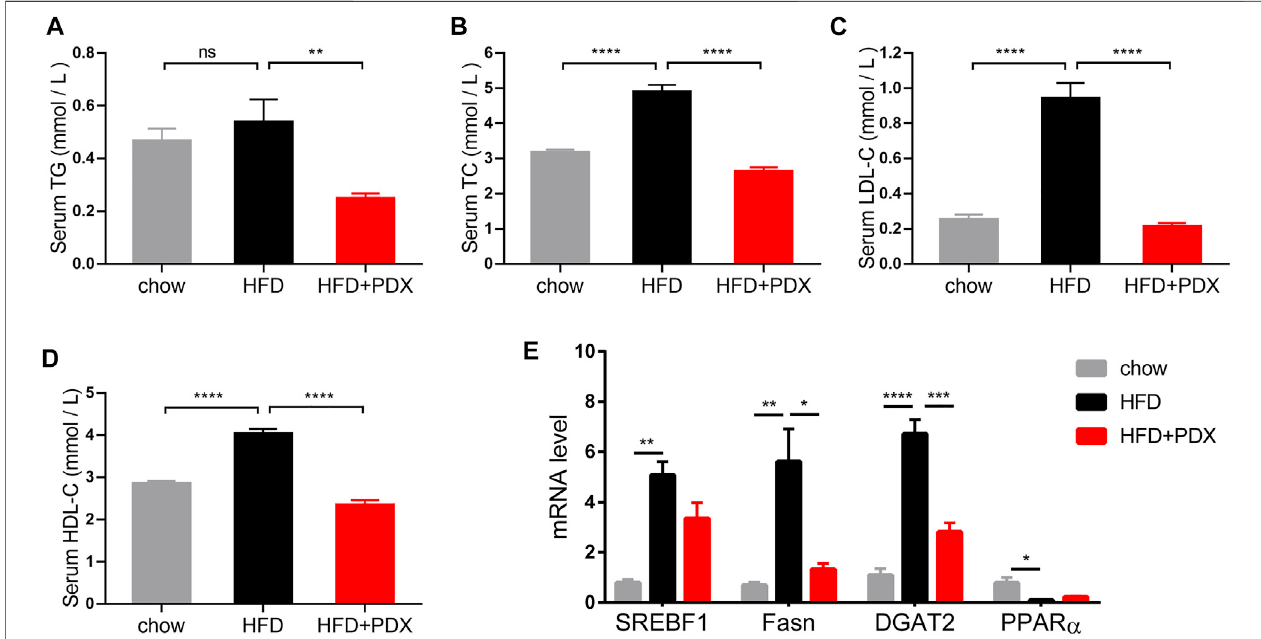
FIGURE 3| PDX prevented dyslipidemiain HFD-fed mice (Part 1). (A) Serum TG. (B) Serum TC. (C) Serum LDL-C. (D) Serum HDL-C. (E) qPCR analysis of genes involved in lipid metabolism SREBF1, Fasn, DGAT2 and PPAR α in epididymal adipose tissue. n (cid:2) 12 (A – D) or n (cid:2) 4 (E) per group. * p < 0.05; ** p < 0.01; *** p <